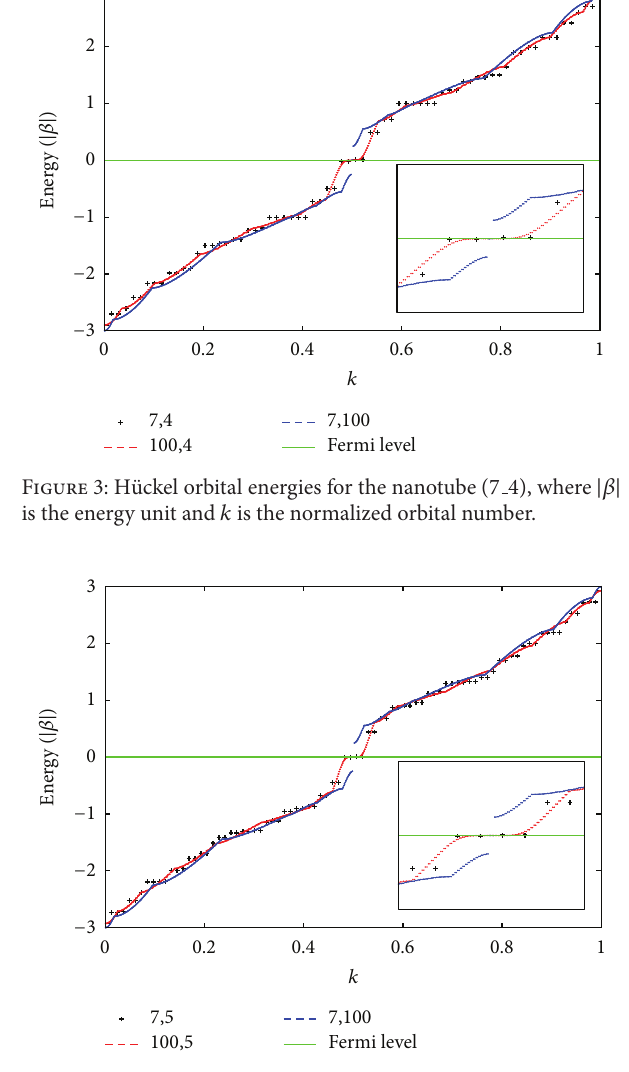
Figure 4: H¨uckel orbital energies for the nanotube (7 5) , where |𝛽| is the energy unit and 𝑘 is the normalized orbital